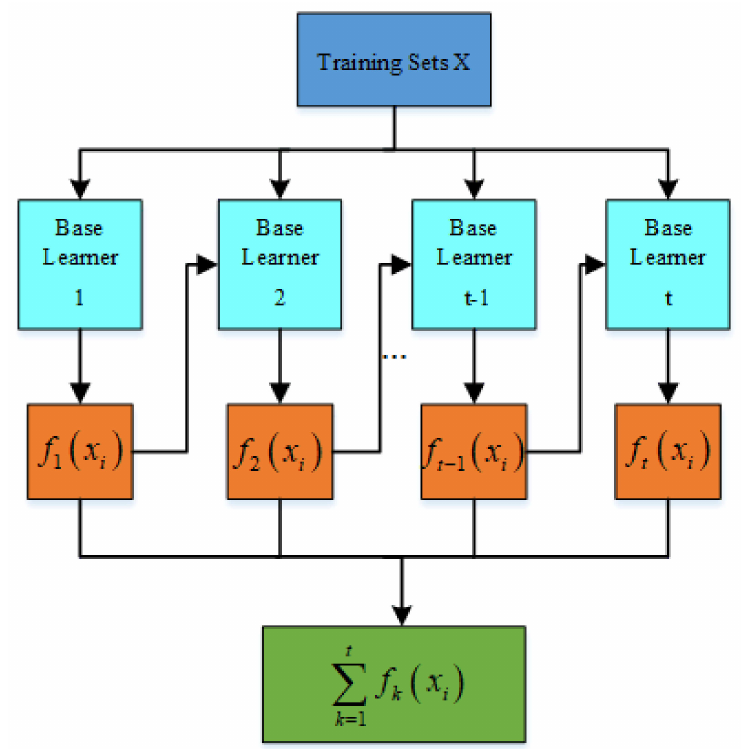
Figure 1. Sequential ensemble learning based on